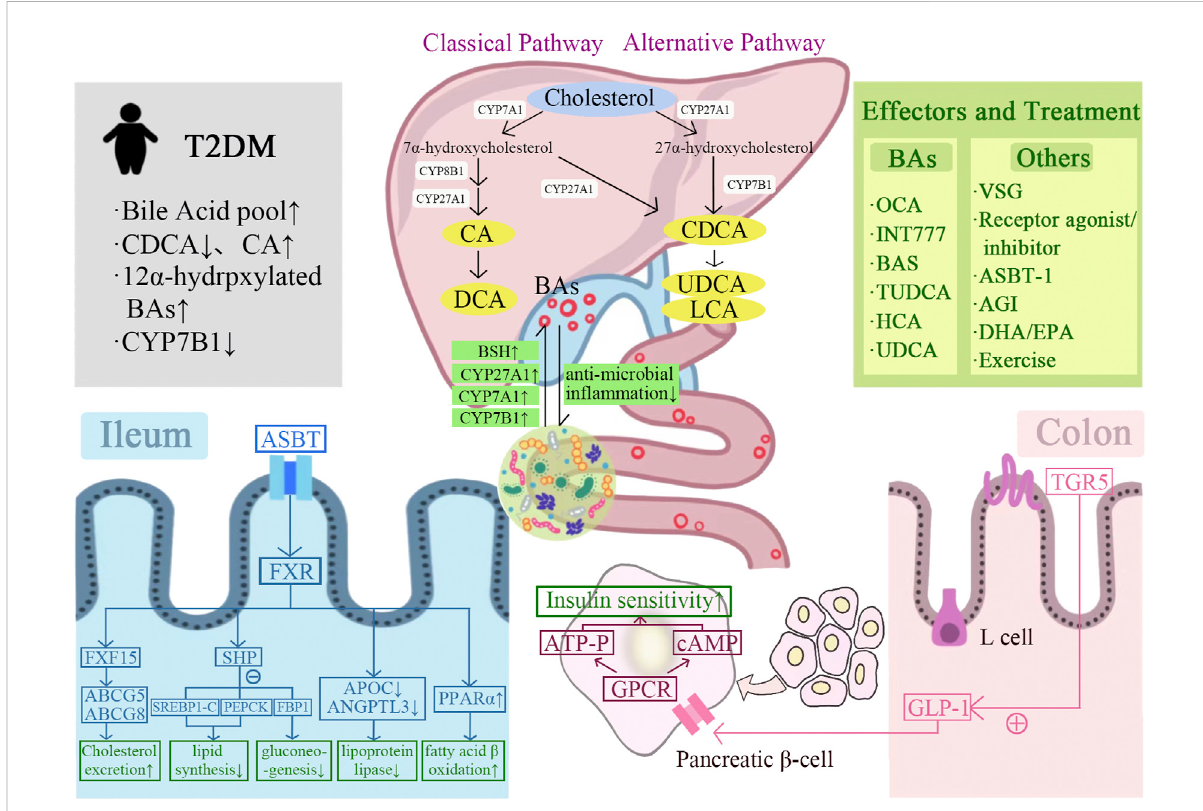
FIGURE 1 Graphical representation of the mechanism of bile acids-gut microbiota crosstalk improves T2DM. BAs are synthesized from cholesterol in the liver via classical and alternative pathways and interact with the gut microbiota. BAs improve insulin sensitivity and T2DM by regulating FXR/TGR5, glucoseandlipidmetabolism,andGLP-1 secretion.Avariety ofBAsandtheirderivativescontributetothetreatment ofT2DM,includingOCA,INT77, BAS, TUDCA, HCA, and UDCA. In addition, T2DM can also be improved by other treatments, including bariatric surgery, receptor agonists/ inhibitors, ASBT-1, AGI, DHA/EPA, and